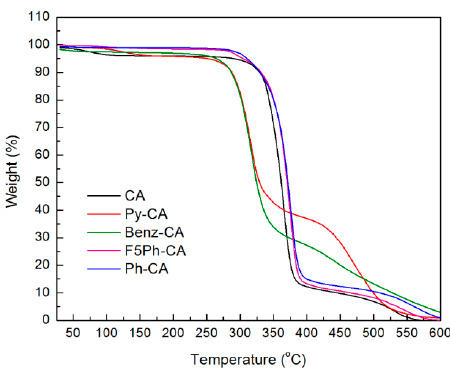
Figure 2. TGA curves of functionalized cellulose acetates including CA (starting material, DS Ac ~ 1.74), Py-CA, Benz-CA, F5Ph-CA, and Ph-CA.